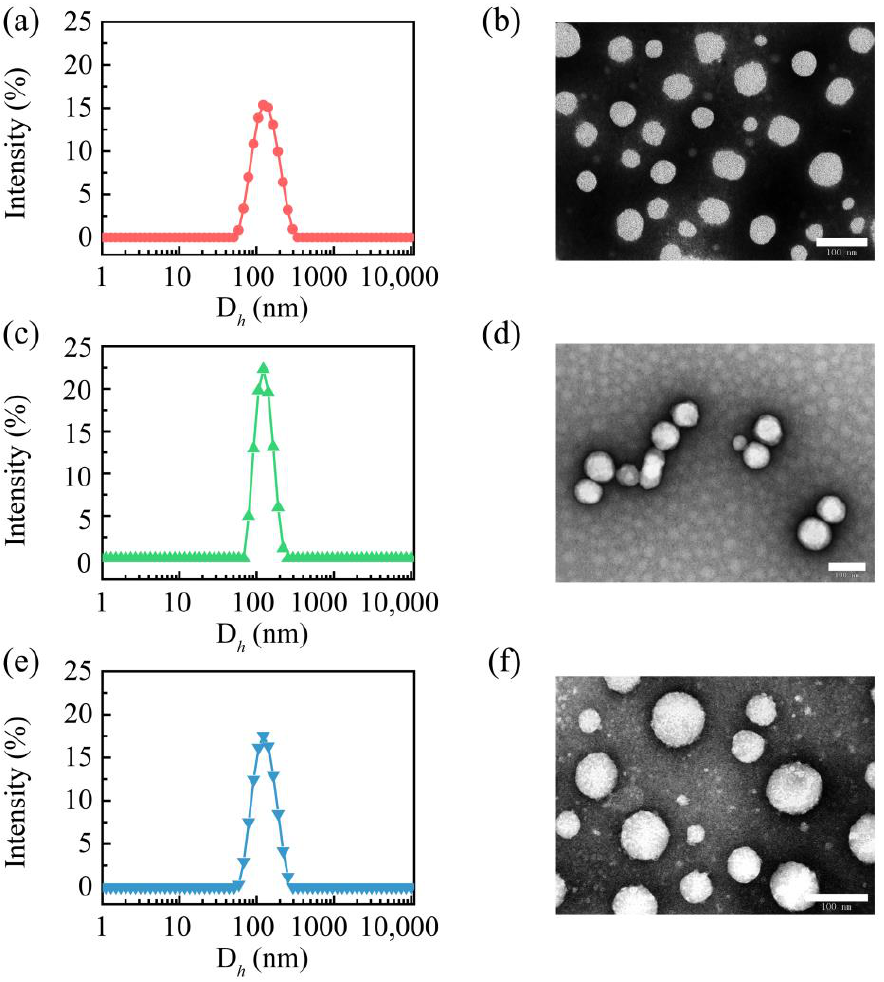
Figure 2. Particle size distribution curves of PEG/CSL ( a ), PEG-C18/CSL ( c ), TEG/CSL ( e ), and TEM images of PEG/CSL ( b ), PEG-C18/CSL ( d ), and TEG/CSL ( f ). Scale bar: 100 nm.